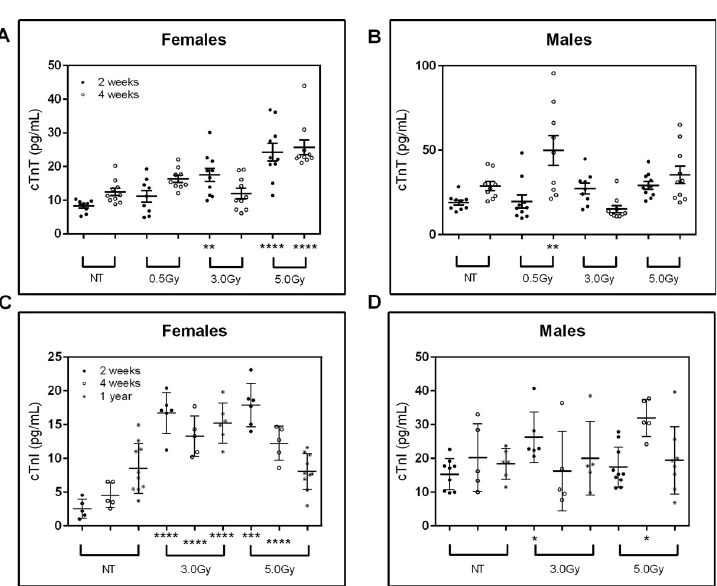
Fig 3. Serum levels of cTnT and cTnI reveal acute cardiomyopathy and long-term abnormalities. Increases in serum cTnT were detected in (A) female and (B) male at two- and four-weeks following irradiation. Serum cTnI levels at necropsy for (A) female and (B) male animals at two, four, and fifty-two weeks following total body irradiation. Bars represent standard error of the mean. NT = no treatment; � p < 0.05, �� p < 0.01, ��� p < 0.001, and ���� p < 0.0001 wrt NT; n =